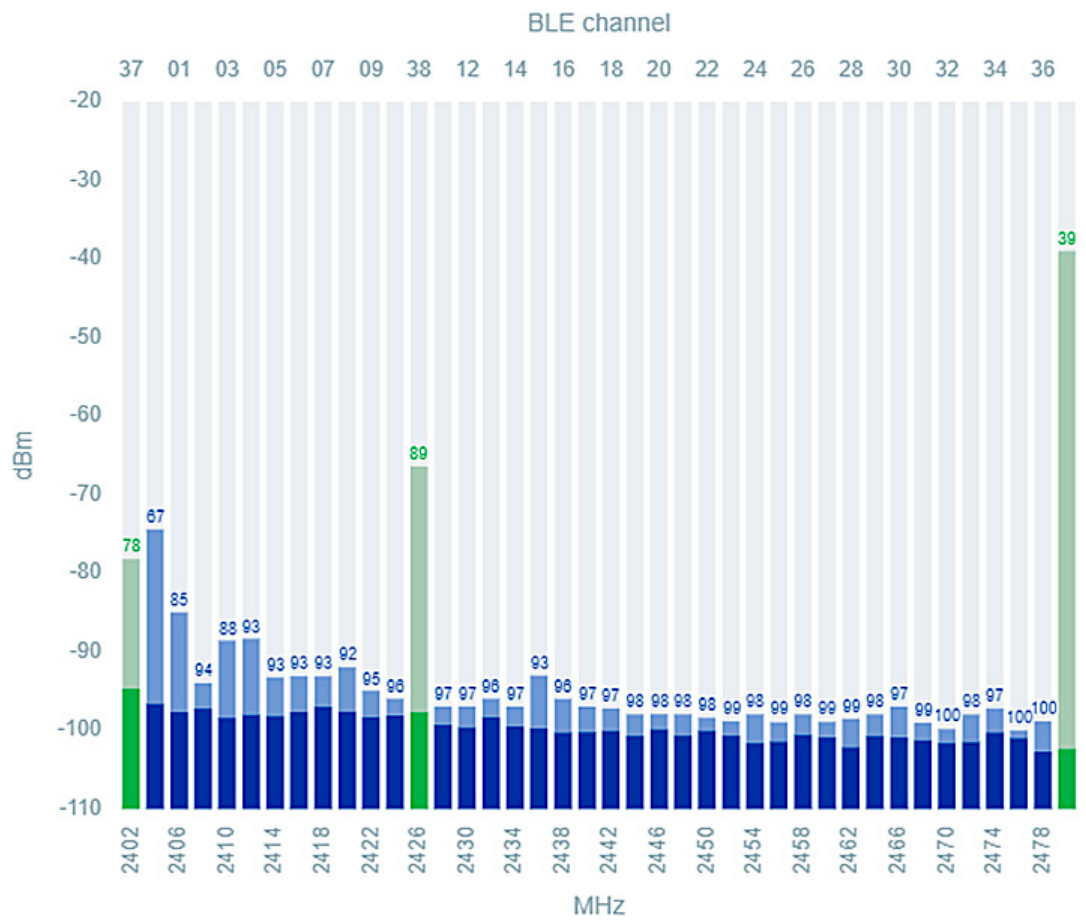
Figure 6. A diagram from the nRF Connect application showing the level of use of the band used by Bluetooth LE, of which channels used for RTI purposes are marked in green (numbers 37, 38 and 39).